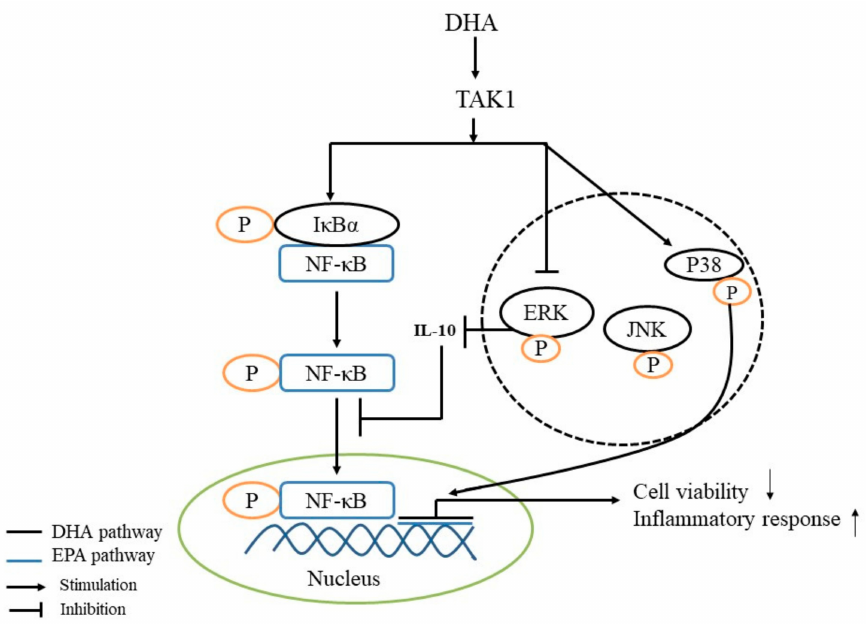
Figure 7. Schematic mechanisms illustrating the DHA-treated BRL-3A for 24 h on the mechanism of inflammatory response